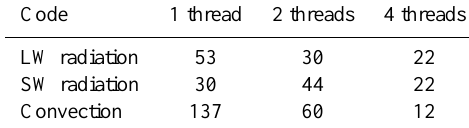
Fig. 5. Simulation speed as a function of processor count. Red triangles show time per model time step, blue circles show a calibrated estimation of model throughput. The annotations show the number of OpenMP threads used and lines show least-squares fits to Amdahl’s law.